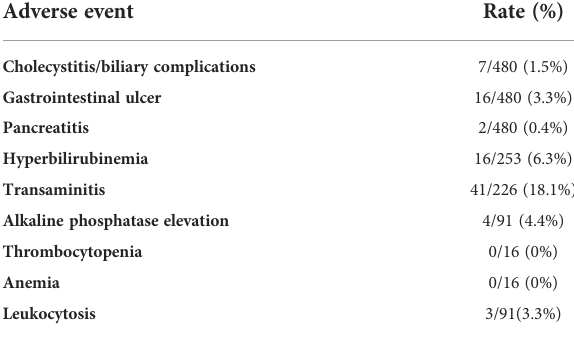
TABLE 3 Adverse effects after yttrium-90 radioembolization sorted by complication type. Adverse event Rate (%) Cholecystitis/biliary